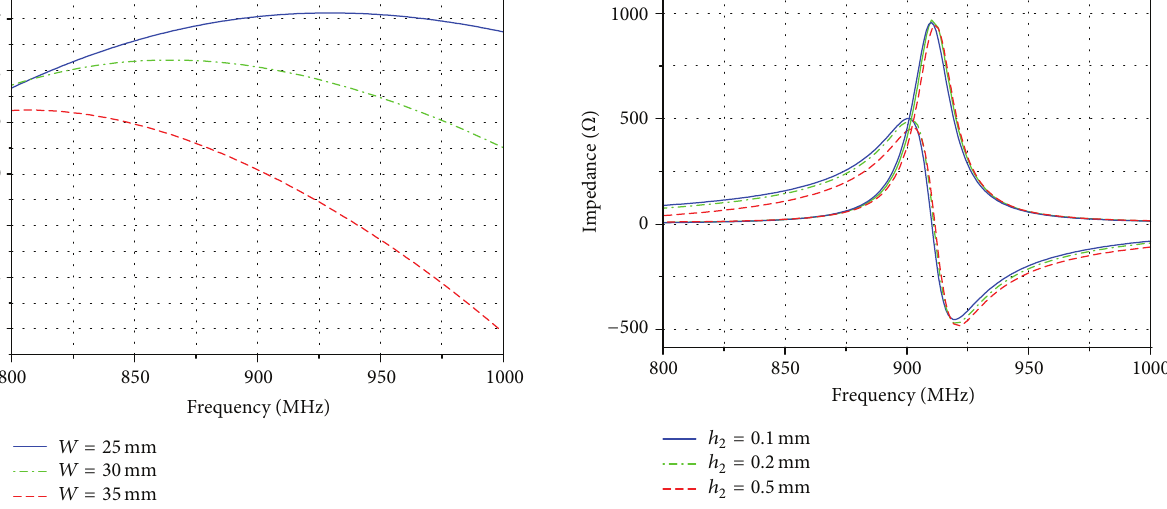
Figure 7: Antenna gain for different widths of the patch.